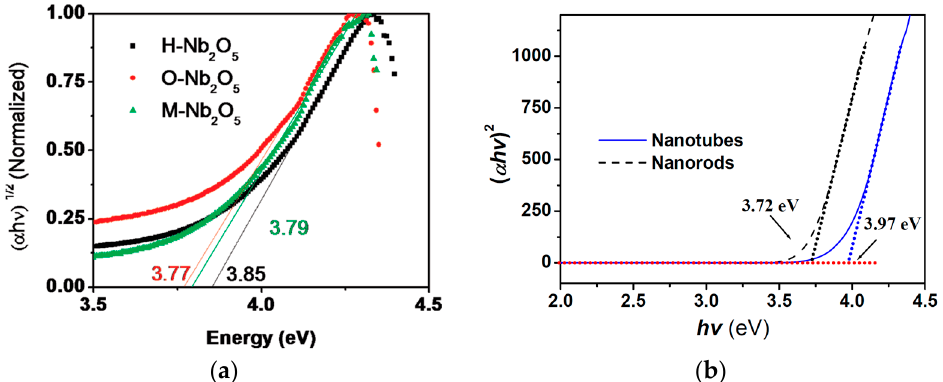
Figure 2. The tauc plot of ( α hv ) 2 against photon energy ( hv ) of ( a ) hexagonal, orthorhombic and monoclinic Nb 2 O 5 nanofibers. Reprinted with permission from [64]. Copyright 2010 ACS Publications. ( b ) orthorhombic Nb 2 O 5 nanorods along with nanotubes evaluated at room temperature. α is defined as the coefficient of absorption [80].